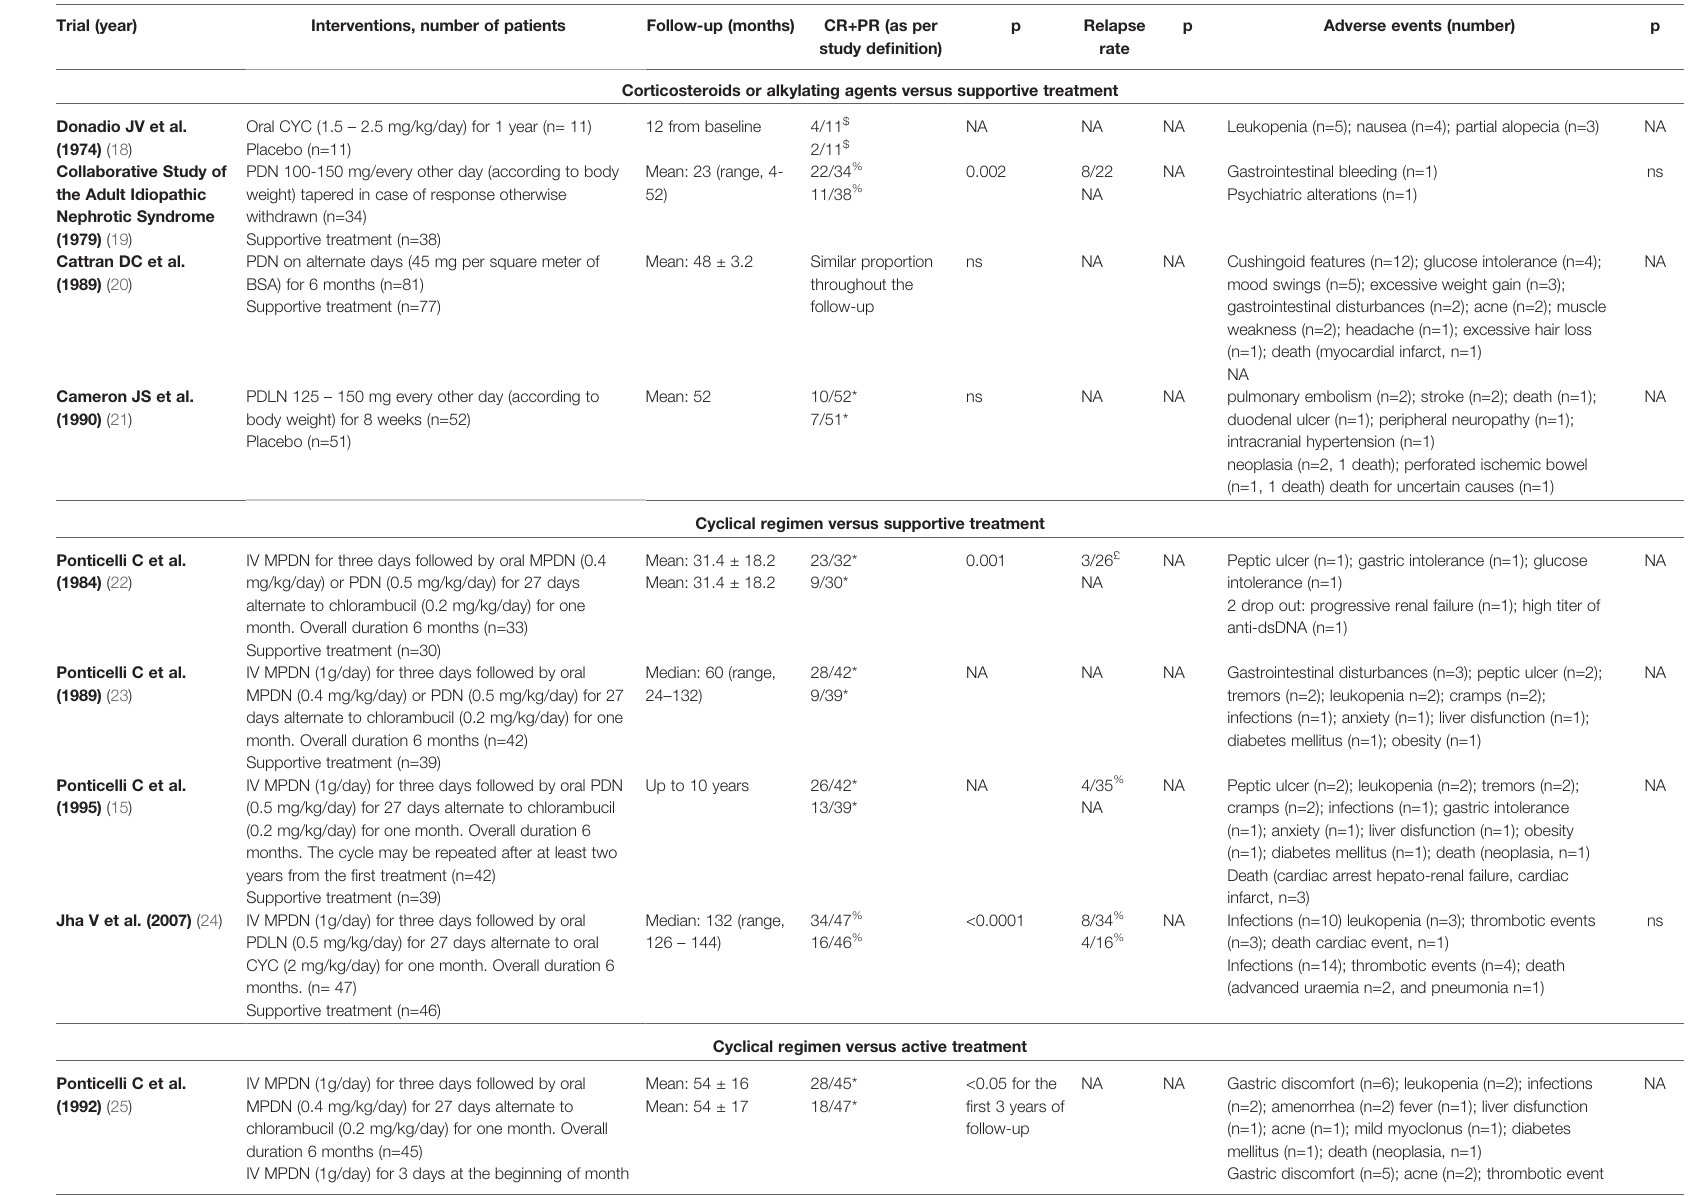
TABLE 1 | Randomized controlled studies in Primary Membranous